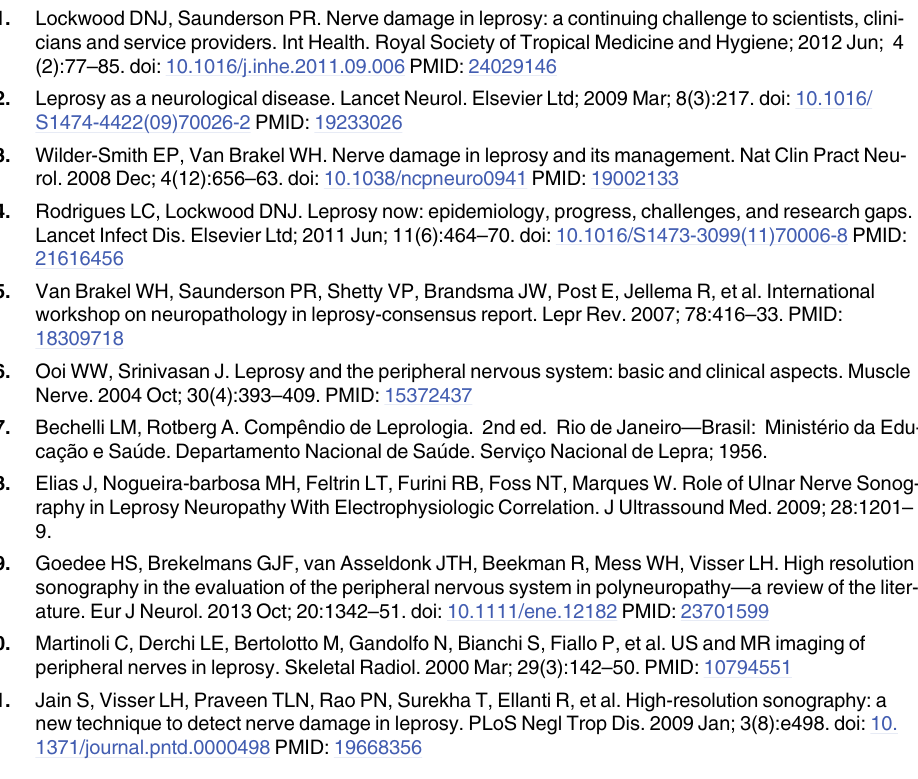
S1 Table. Clinical data and CSA measurements of each patient included in the study. ID: patient identification; RJ: Ridley-Jopling classification; WHO: Operational classification pro- posed by the World Health Organization; Upt: ulnar nerve, proximal to the cubital tunnel; Ut: ulnar nerve at the cubital tunnel; TT: tuberculoid; BT: borderline-tuberculoid; BB: borderline- borderline; BL: borderline-lepromatous; LL: lepromatous; PB: paucibacillary; MB: multibacil- lary; NP: measurement not performed (amputation, cutaneous ulcers or other cutaneous alter- ations at the site of